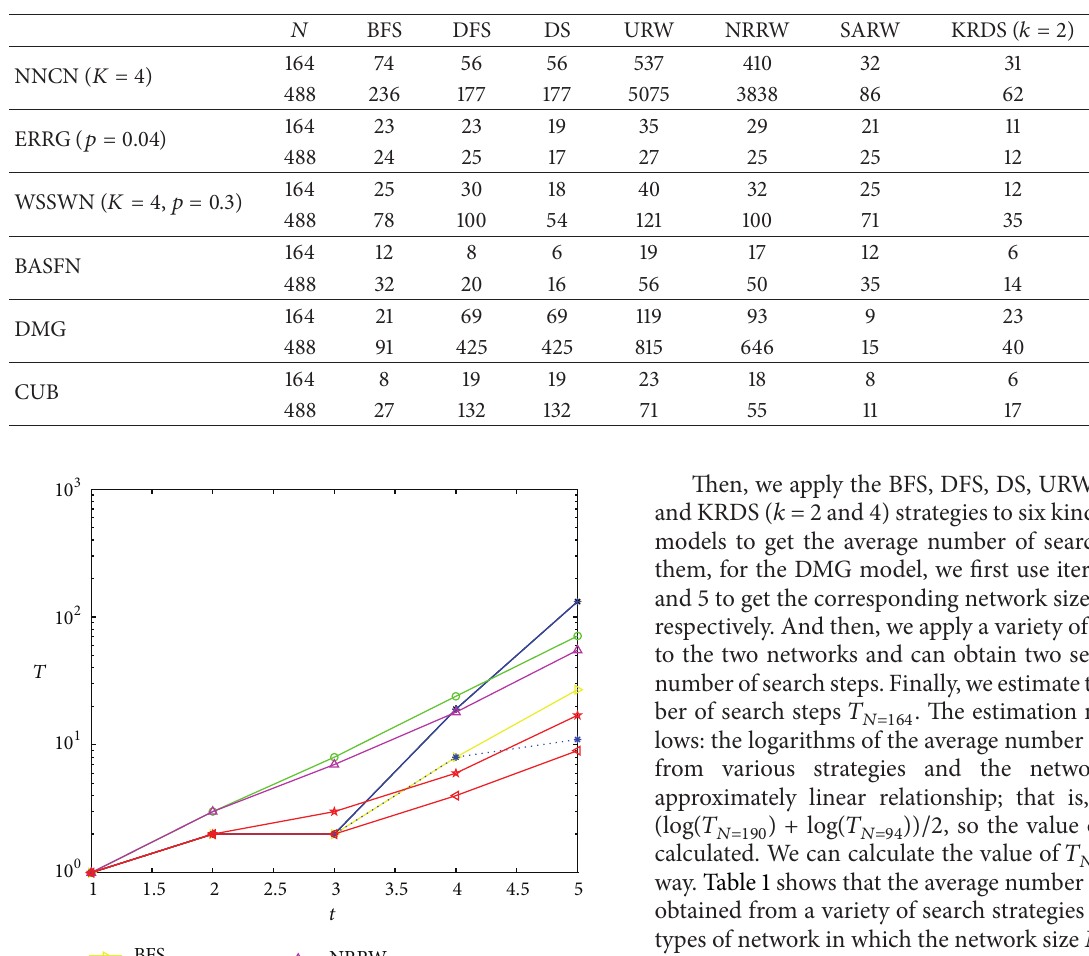
Table 1: The number of search steps.